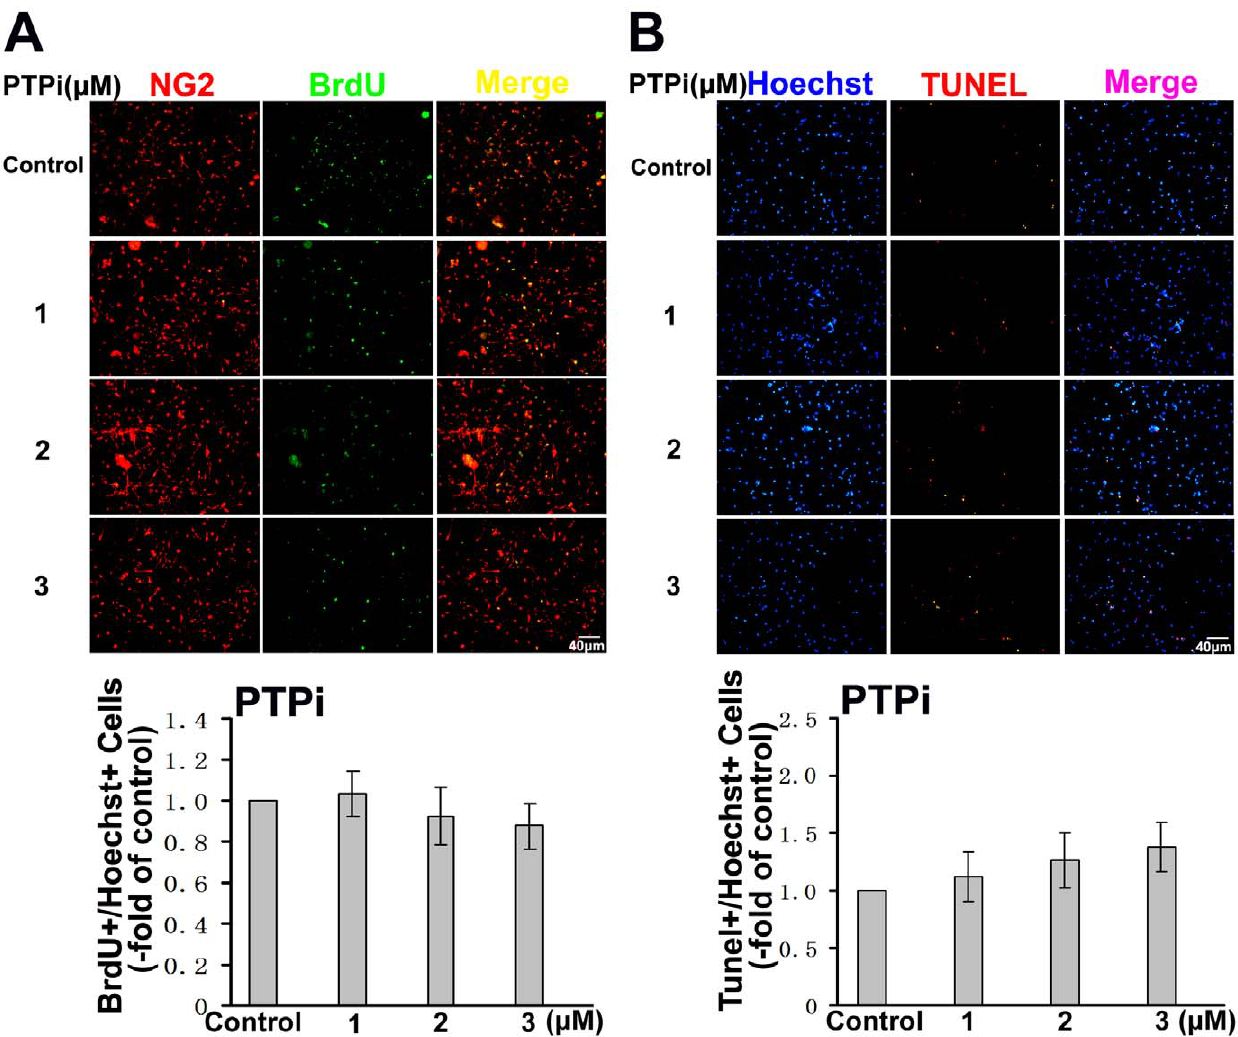
Figure 5. The effect of PTPi IV on proliferation and apoptosis of the OPCs in vitro. ( A ) The OPCs were cultured in different concentration of PTPi IV for 8 h with 10 m M BrdU. OPCs were labeled with NG2 antibody (red), and proliferated cells were labeled with anti-BrdU (green). The culture without PTPi IV was used as control and quantification was presented as fold of control. Ratio of BrdU-labeled cells was calculated. Data shown are the mean 6 S.D. of three independent experiments. ( B ) Apoptotic cells were detected by TUNEL staining (red), and the total number of cells were identified by Hoechst staining (blue). The culture without PTPi IV was used as control and quantification was presented as fold of control. Ratio of TUNEL-labeled cells was calculated. Data shown are the mean 6 S.D. of three independent